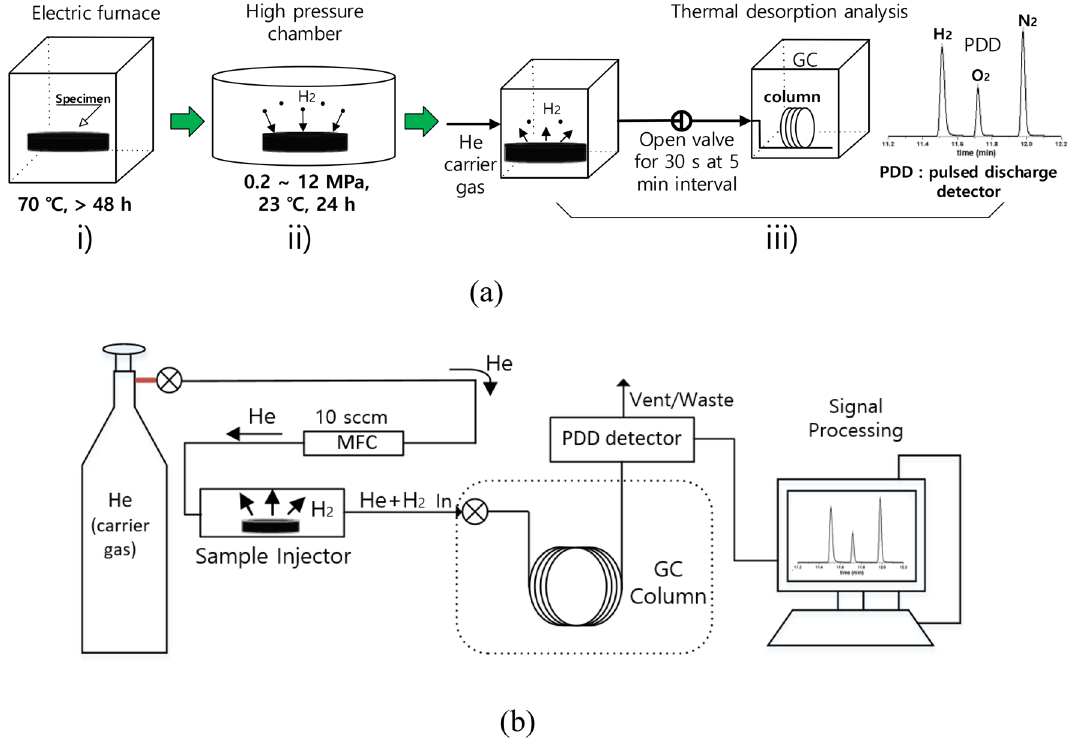
Figure 2. ( a ) Schematic diagram of entire TDA-GC measurement procedure, ( b ) configuration of TDA-GC